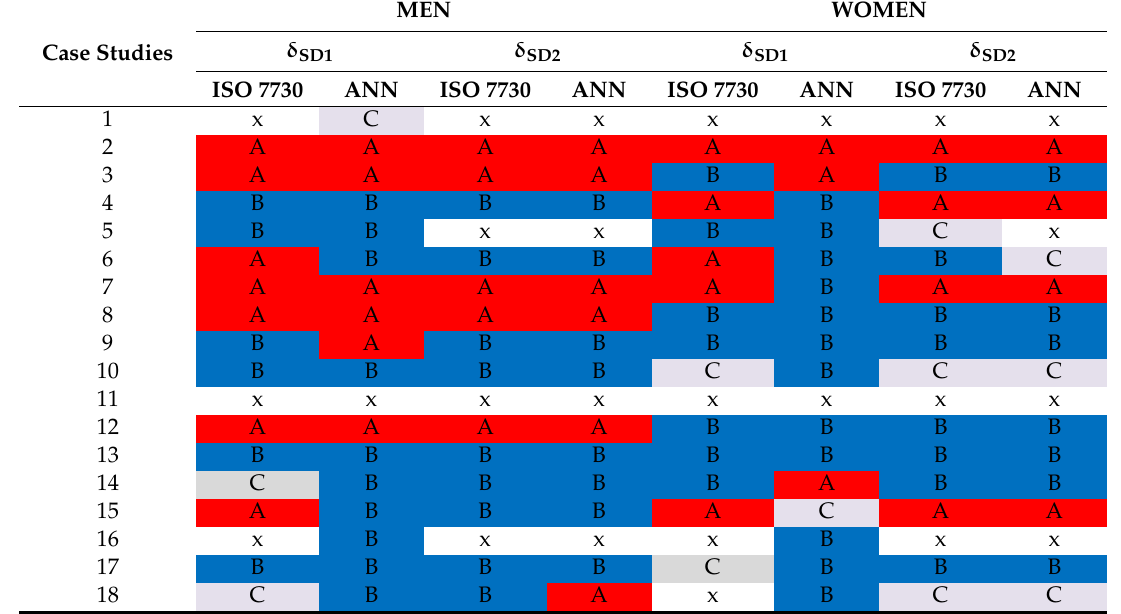
Figure 11. Comparison between the mean values of PMV and PPD indices for men and women configurations ( referred to δ SD1 and referred to δ SD2 ). (cid:50) (cid:35) Table 8. Thermal comfort class Comparison assigned for each case study.